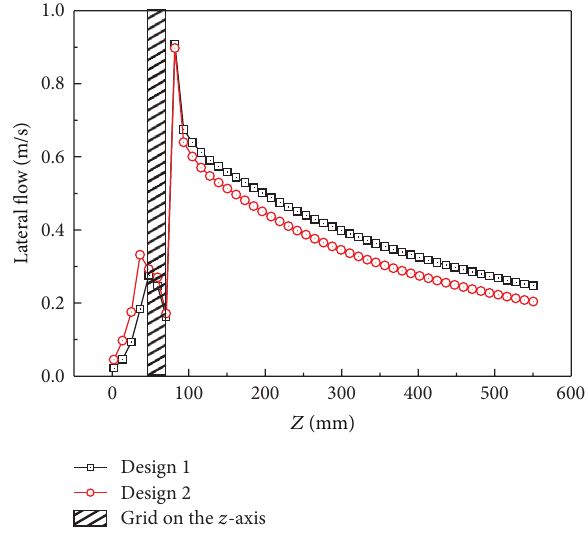
Figure 5: Lateral flow